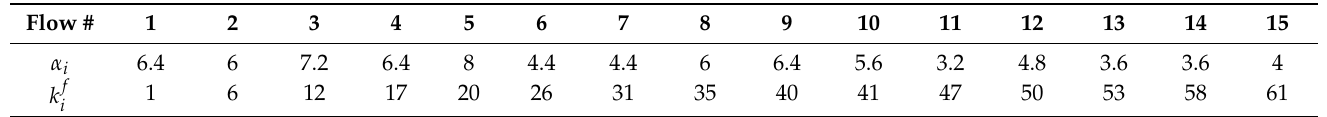
Table 3. Packet flow